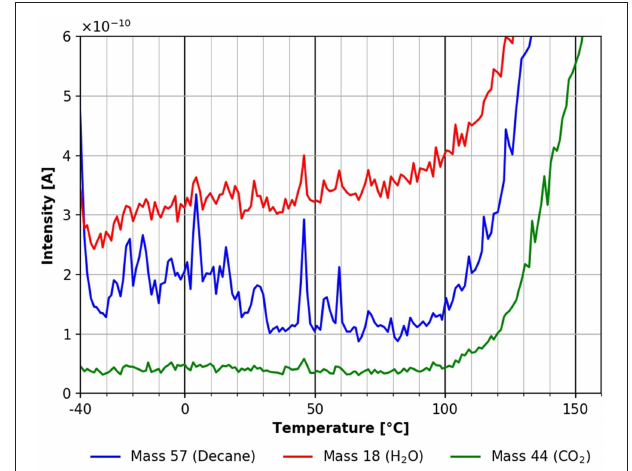
FIGURE 6 | Zoom into the TPD spectrum shown in Figure 5 . n-decane (mass 57, blue), carbon dioxide (mass 44, green), and water (mass 18, red).